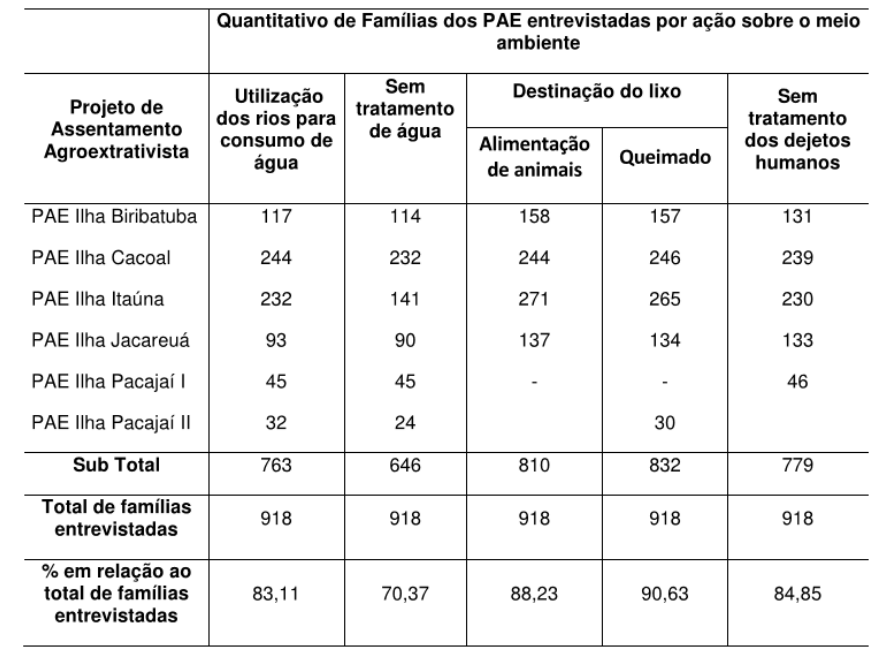
Tabela 2: Ações dos moradores dos PAE sobre o meio ambiente.